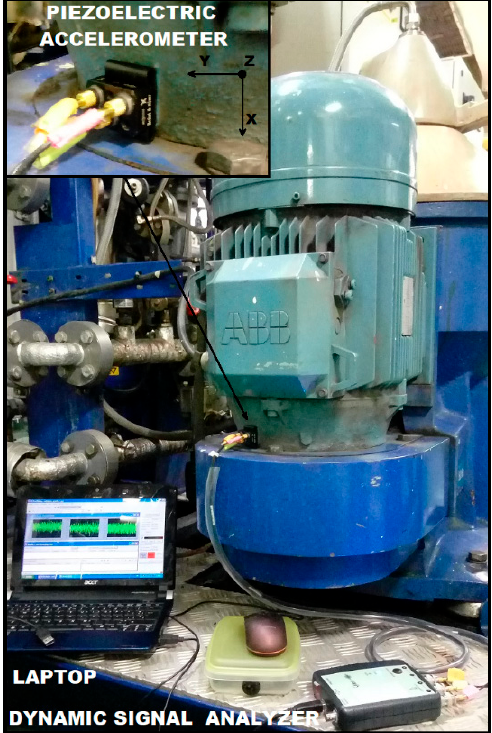
Figure 3. Final arrangement for vibration measurement.